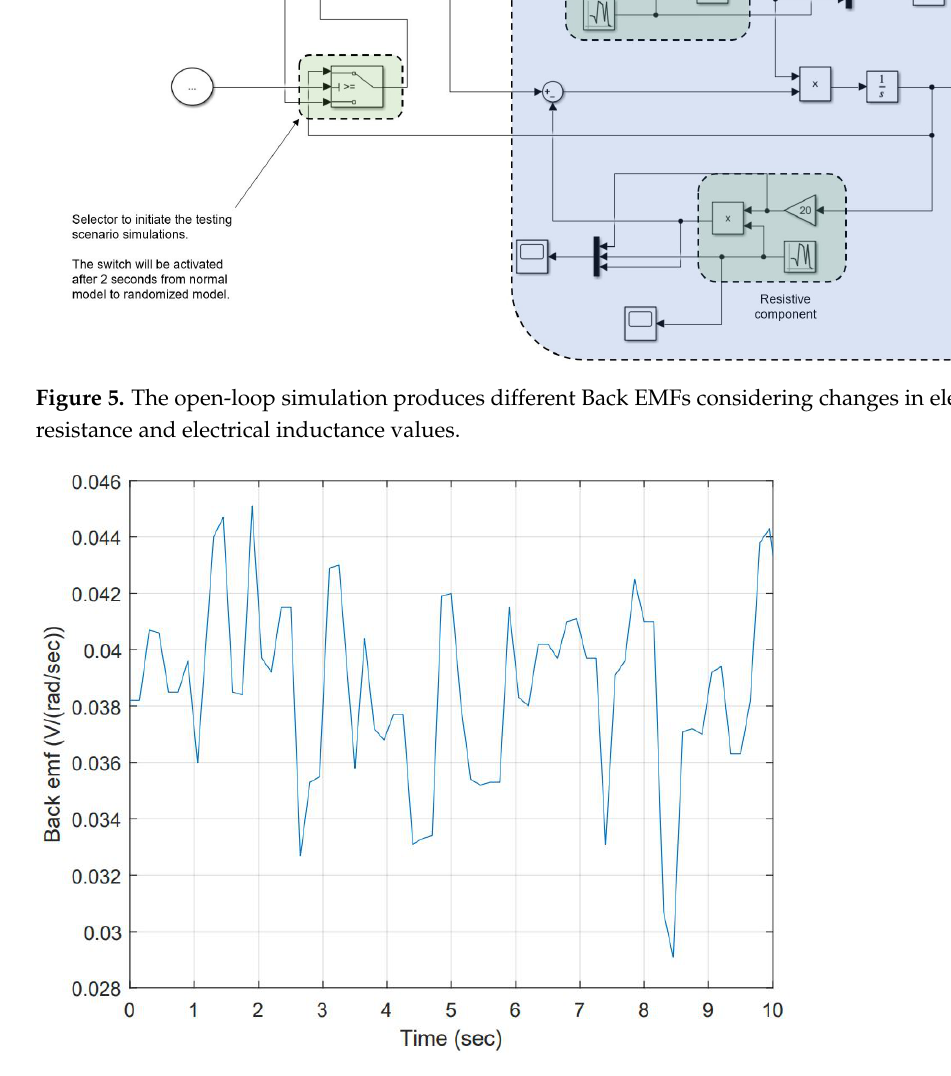
Figure 6. Data collection from simulation for Back EMF. This data collection is presented in